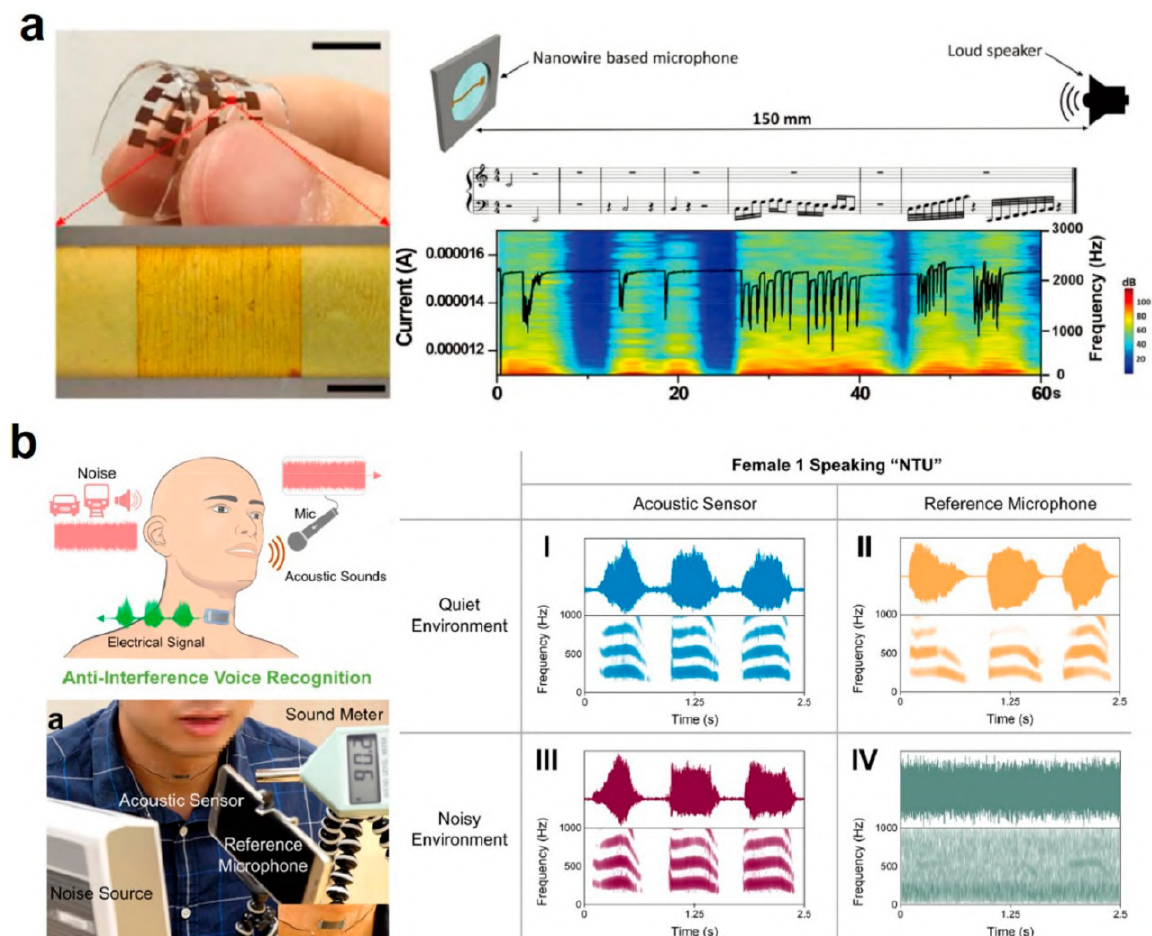
Figure 8. Acoustic metamaterials for sound recognition. ( a ) Photograph of the soft nanowire-based acoustic metamaterial membrane, schematic of the experimental setup of music detection, and acoustic sensor output (curve) and the STFT analysis of the background in response to notes with different music scale. Reproduced with permission from [117]. Copyright 2020, Wiley. ( b ) Schematic and photograph of the flexible anti-interference voice recognition acoustic metamaterial sensor, performance comparison of the phonation of “NTU” by the fabricated acoustic sensor and a reference microphone at quiet and noisy environments. Reproduced with permission from [119]. Copyright 2020, American Society of